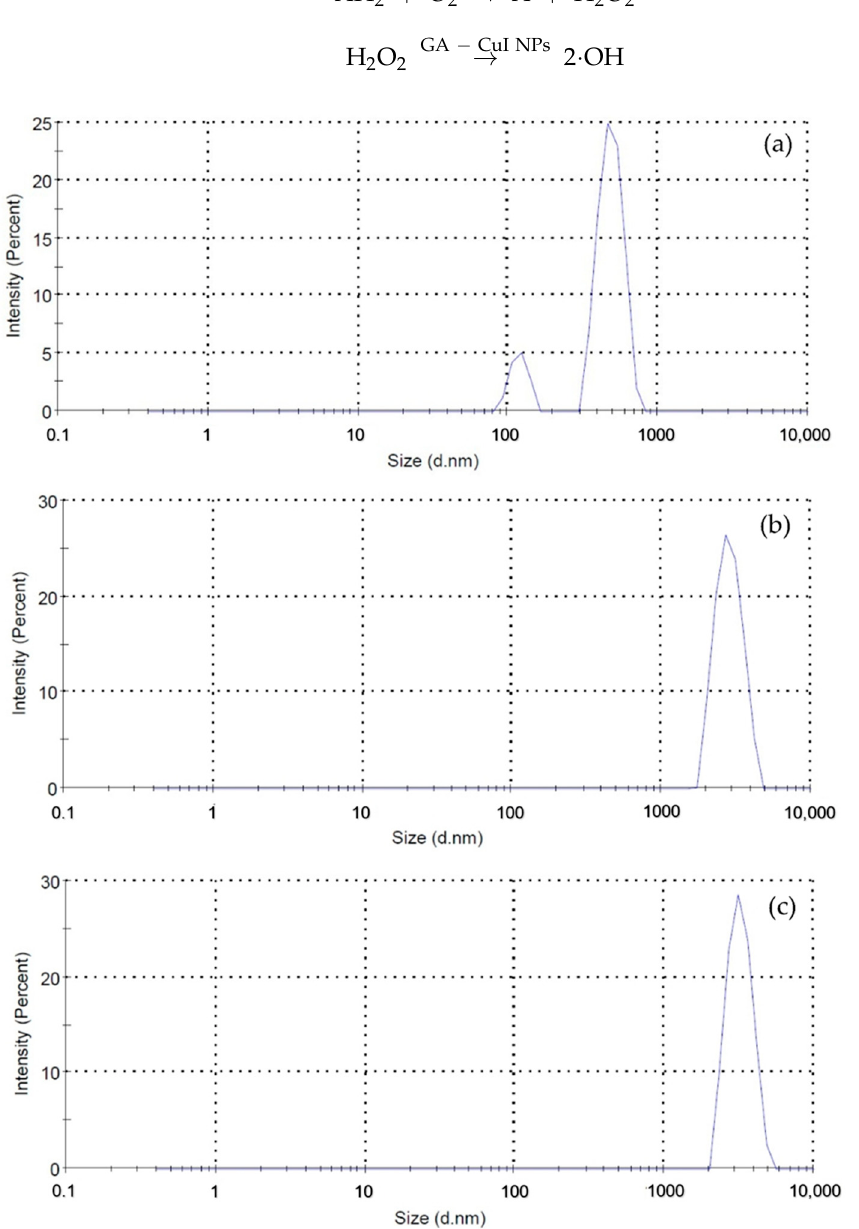
Figure 5. Size distribution of ( a ) CuI NPs, ( b ) 2.5 GA-CuI NPs, and ( c ) 5.0 GA-CuI NPs determined using a